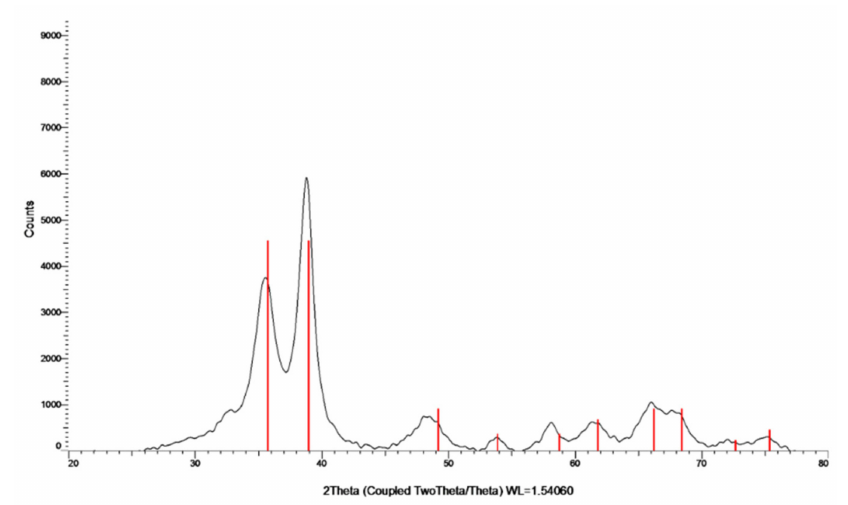
Figure 2. XRD pattern of Zn–CuO NPs; the red lines belong to the monoclinic CuO